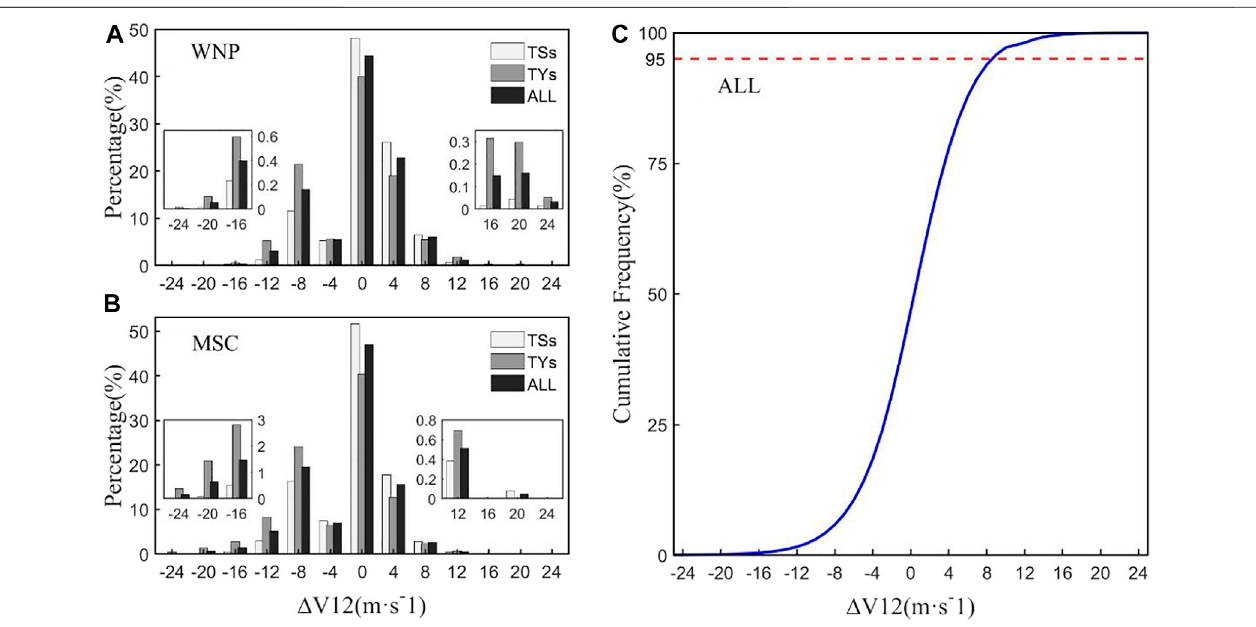
FIGURE2|(A,B) Thefrequencyand (C) cumulativefrequencydistributions of12-hintensitychange Δ V 12 strati fi edbyTCintensityat0 hover (A) theWNPand (B) the MSC. The distributions are provided for tropical storms and severe tropical storms (TSs) (17.2 m s − 1 ≤ Vmax ≤ 32.6 m s − 1 ), typhoons and super-typhoons (TYs) (Vmax ≥ 32.7 m s − 1 ), and all TCs. Vmax, TC intensity.